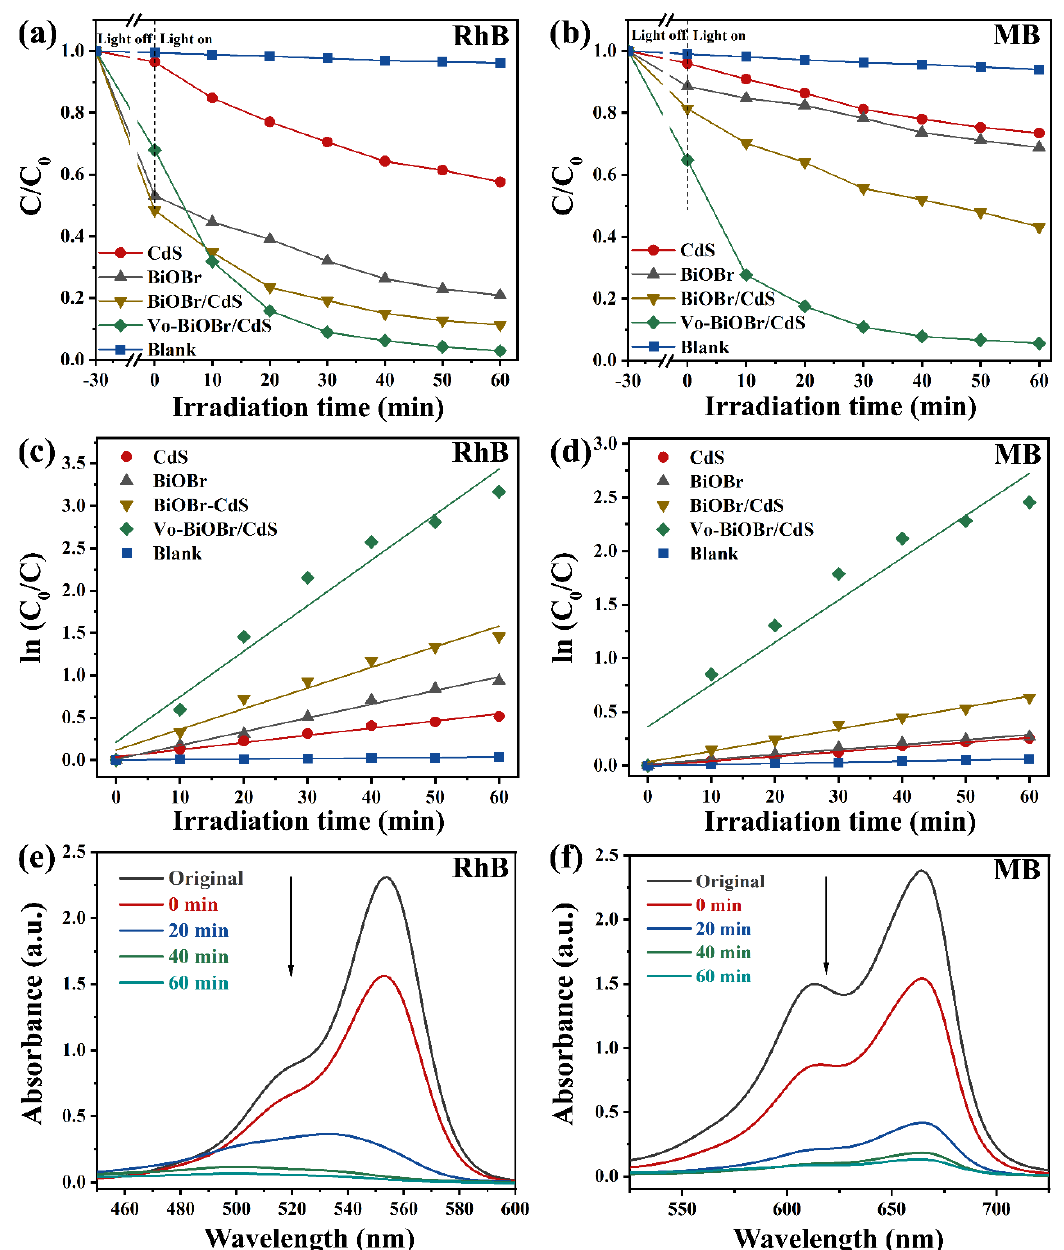
Figure 6. ( a , b ) The removal efficiency of RhB and MB over BiOBr, CdS, BiOBr/CdS, and Vo-BiOBr/CdS under the irradiation of LED light; ( c , d ) Pseudo-first-order-kinetic fitting curve; ( e , f ) Time-dependent absorption spectra of degrading RhB and MB.